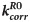
Histogram plot of error between measurements of different observers (n = 3) for stiffness values kR0, kcuto, knimble, kcorrR0 and kcorrcuto.The error is defined as the percentage difference of each measured parameter with respect to the mean value for that sample. Root mean square (RMS) is indicated for each parameter (RMSR0 = 19%, RMScuto = 46%, RMSnimble = 24%, RMScorrR0 = 13% and RMScorrcuto = 53%).